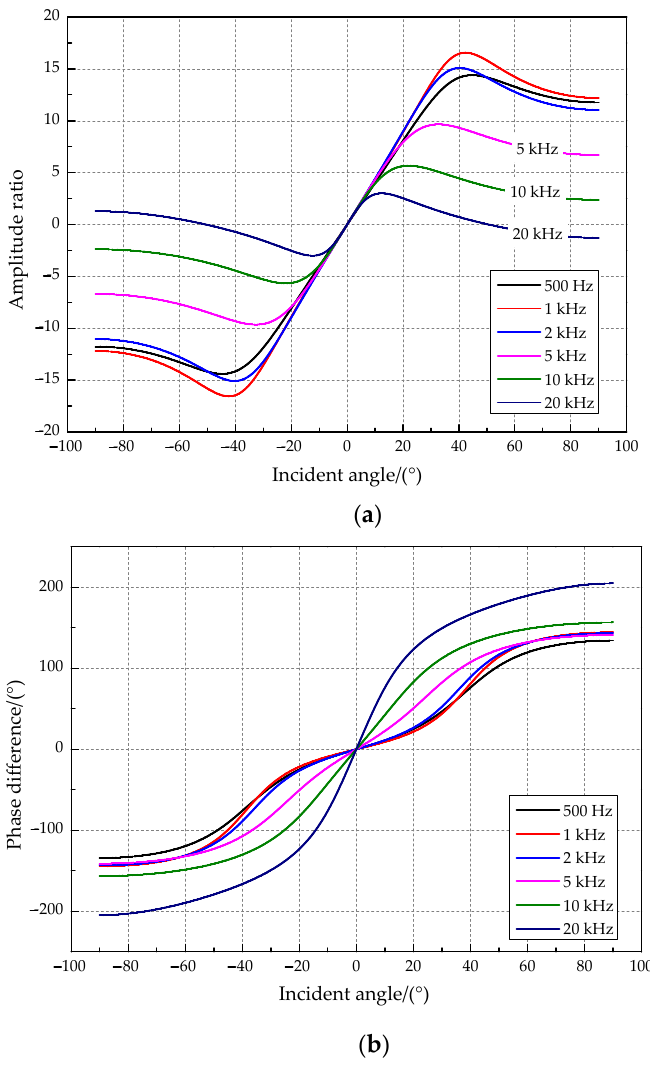
Figure 5. The relationship between key parameters and the incident angle. ( a ) The amplitude ratio and the incident angle. ( b ) The phase difference and the incident angle.